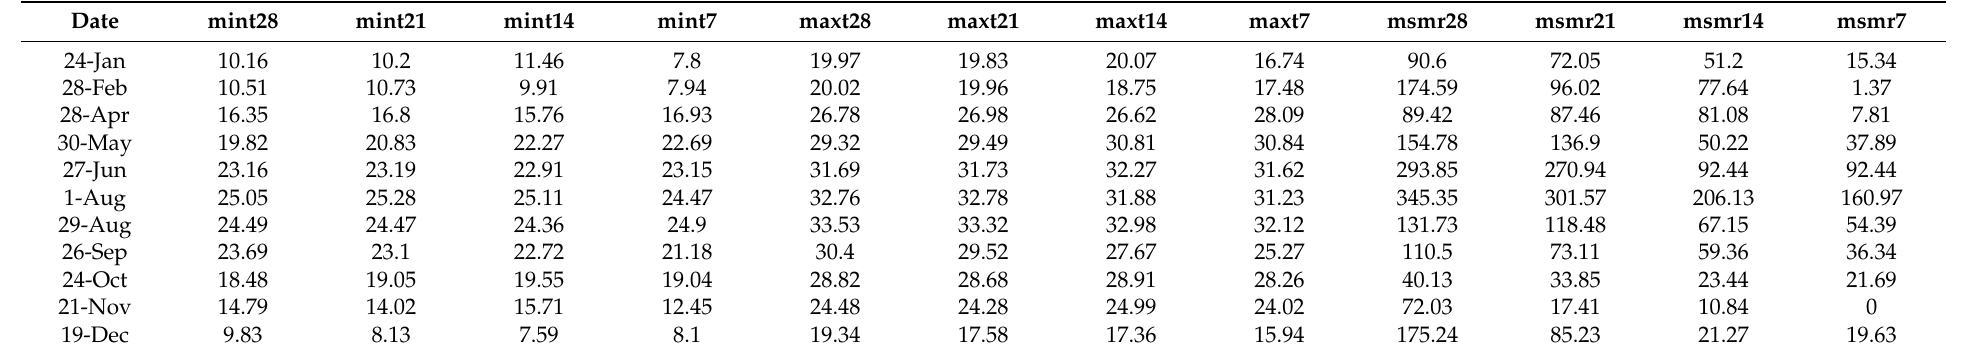
Table A3. Table listing meteorological estimates for each sampling date across the city. Data were derived from NASA DAYMET https://daymet.ornl.gov/